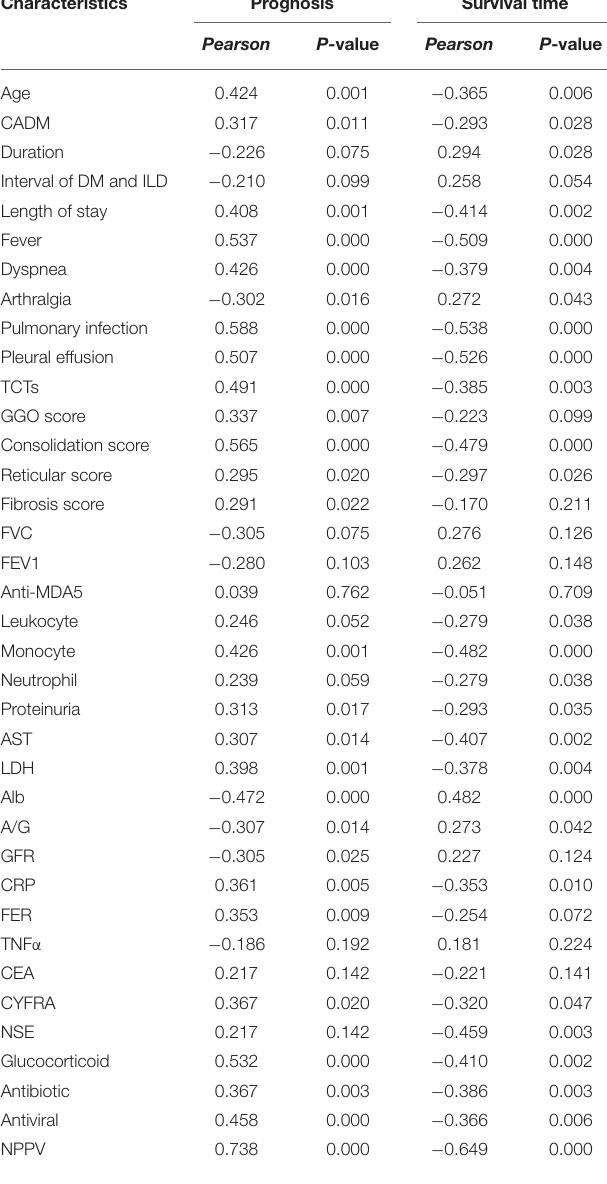
TABLE 5 | Correlation analysis of clinical characteristics and